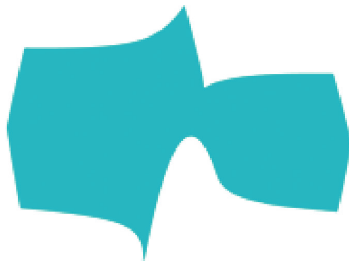
Figure 11: Explicit surface.